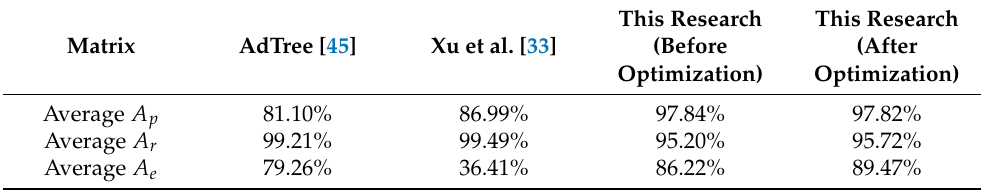
Table 4. Quantitative